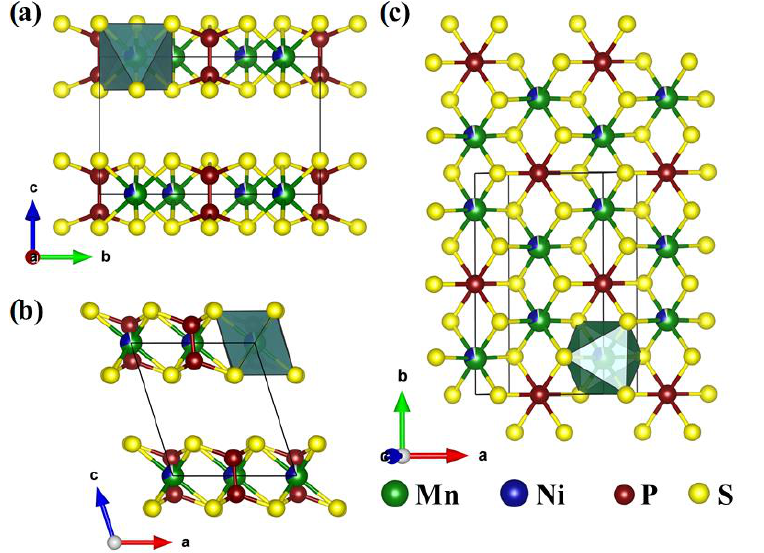
Figure 5. As an example crystal structure of (Mn 0.7 Ni 0.3 ) 2 P 2 S 6 ( a ) shown in the bc plane, ( b ) shown in the ac plane and ( c ) shown in the ab plane. The graphical representation was prepared using VESTA3 [44]. The Rietveld refinement of the X-ray data was carried out using the FULLPROF soft- ware for a 30% substituted sample, i.e., (Mn 0.7 Ni 0.3 ) 2 P 2 S 6 . The measured pattern (red circles) is shown in Figure 6 together with the calculated pattern based on the Rietveld analysis (black line), the difference between measured and calculated pattern (blue line), and the calculated Bragg positions for a monoclinic unit cell with the space group C2/m . The cal- culated peak positions and intensities are in satisfactory agreement with the experimental data. Table 2 summarizes the results of the structural refinement and the lattice parame- ters. Note that the presence of a high concentration of stacking faults is a well-known problem in layered vdW compounds and was observed for Ni 2 P 2 S 6 in Refs. [45,46]. More- over, stacking faults in the samples manifest by an asymmetry of the 00l reflections in the pXRD patterns. This might explain the high value of our R-factor from our X-ray analysis.